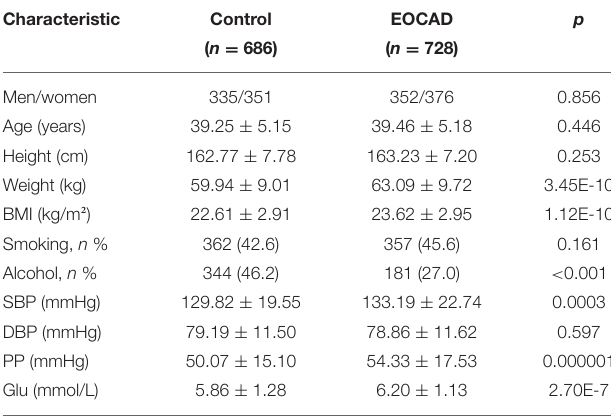
TABLE 1 | Comparison of demographic, lifestyle characteristics of